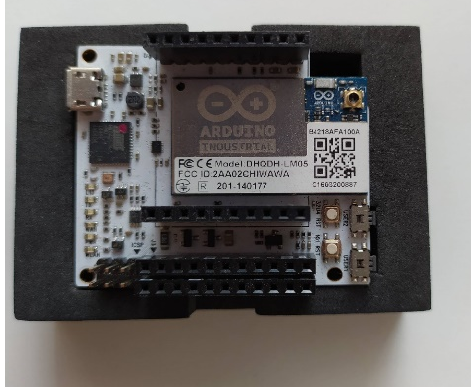
Figure 5. Arduino Industrial Board.